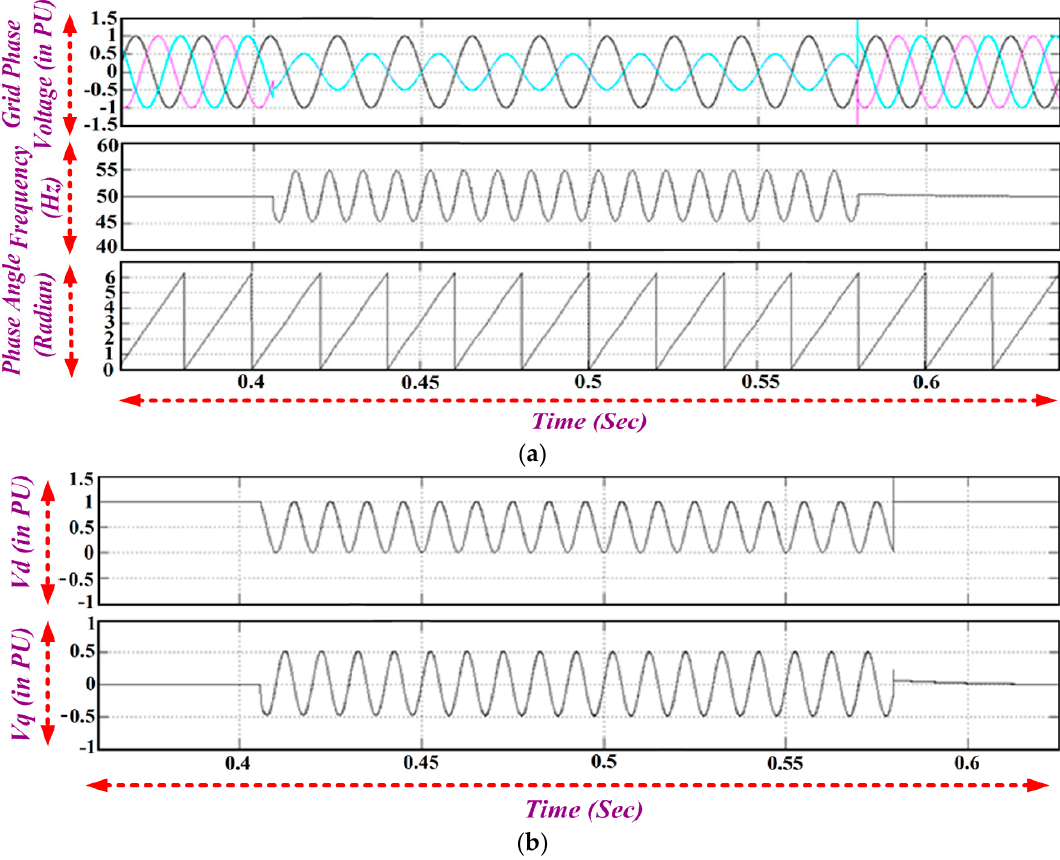
Figure 20. ( a ) Frequency and Phase Angle Variation during a Line to Line Fault; ( b ) q- axis and d- axis Voltage Magnitude during a Line to Line Fault.